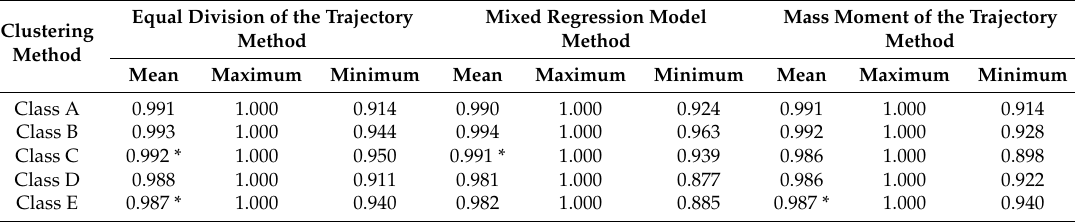
Table 5. Cosine similarity statistics of TC trajectories in different classes obtained by the various trajectory clustering